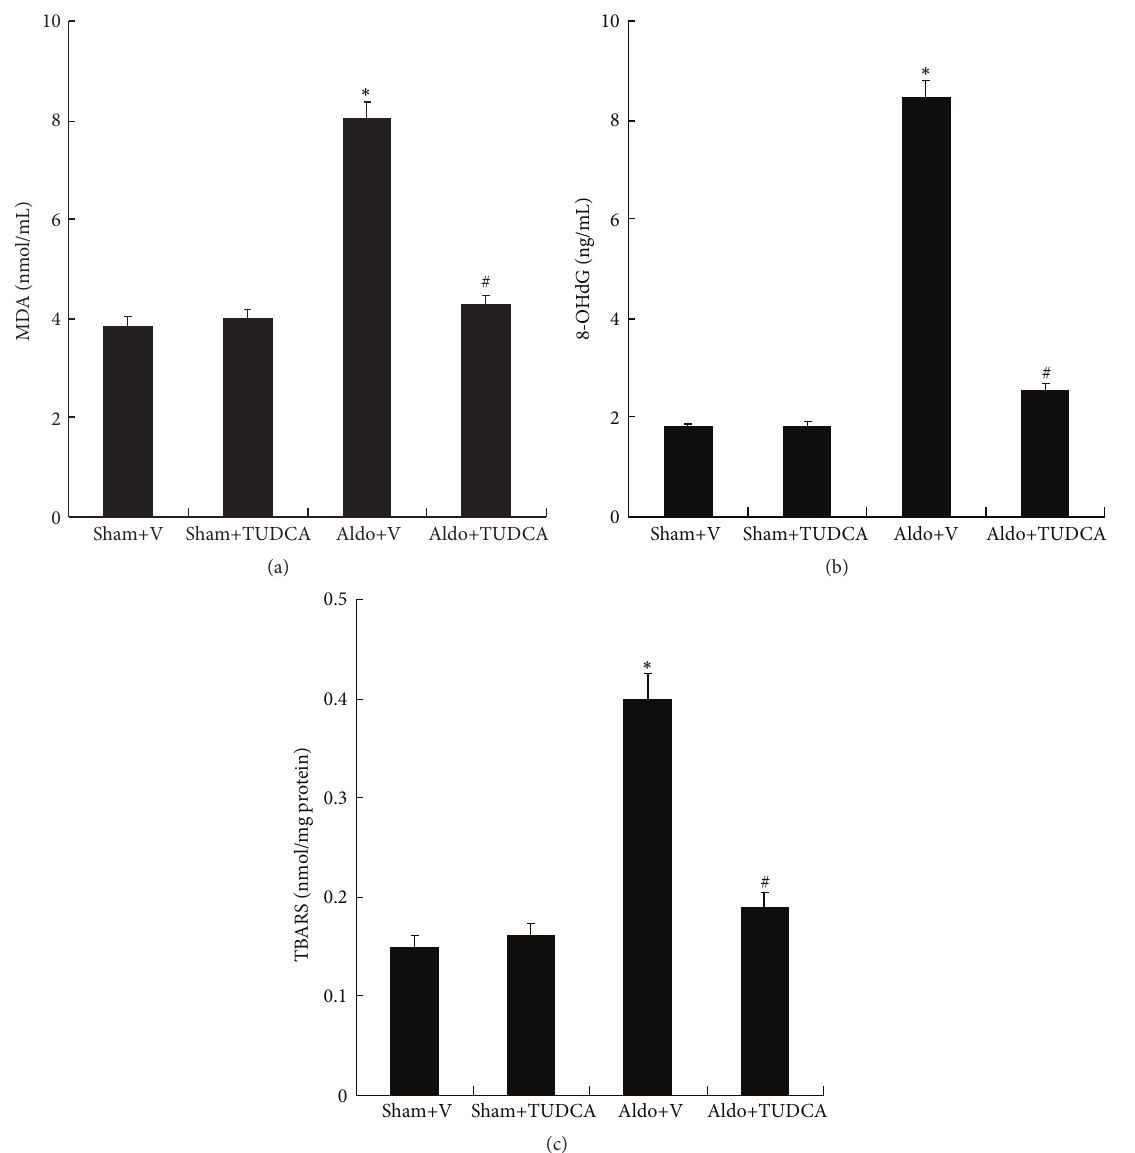
Figure 3: ROS levels in the mouse kidney. (a) MDA, (b) 8-OHdG, and (c) TBARS were detected according to the manufacturer’s protocol. Values are mean ± SEM ( 𝑛 = 6 ). ∗ 𝑝 < 0.05 , Sham+V group versus Aldo+V group, # 𝑝 < 0.05 , Aldo+V group versus Aldo+TUDCA